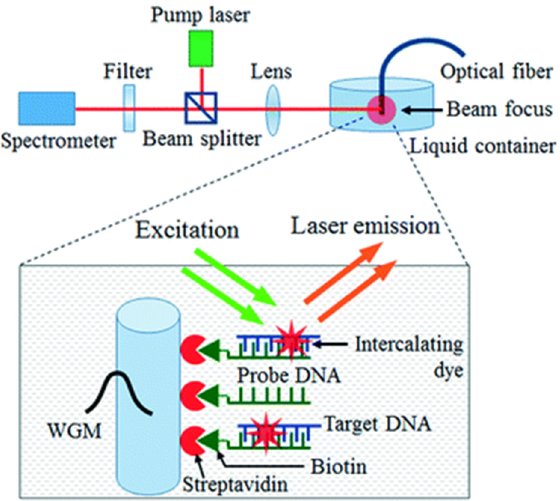
Figure 10. Fiber OFRR in liquid environment is confocally pumped with an OPO laser source, where the evanescent field of the guided WGM interacts with surface-attached molecules and provides feedback for lasing phenomena [74].